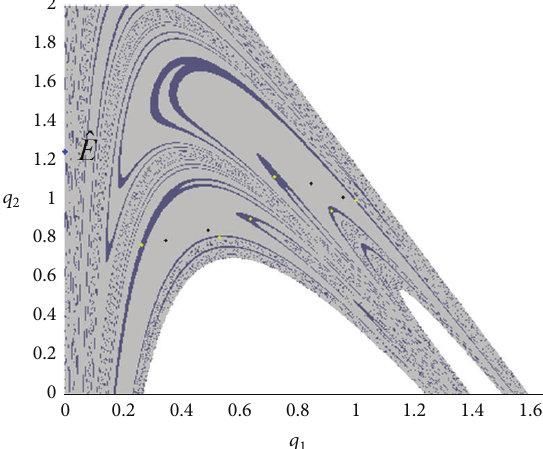
Figure 7: Parameter set: 𝑎 = 3 , 𝑏 = 1 , 𝑐 = 0.5 , and 𝛾 = 0.963 . Coexistence of interior attractors for 𝛼 = 1.498